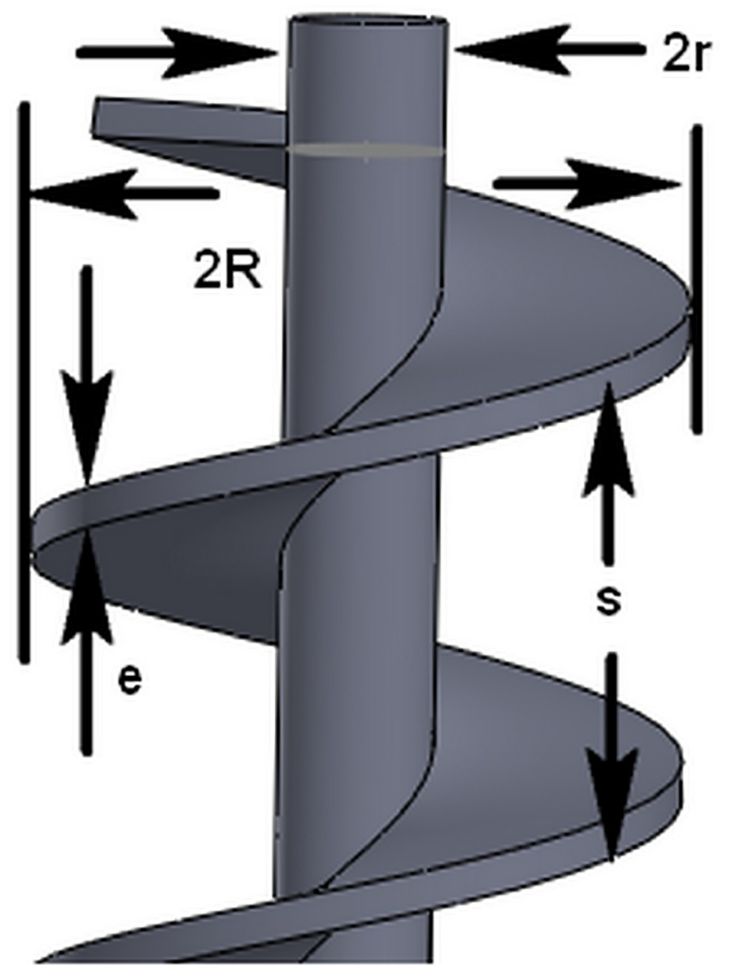
Fig 2. Schematic view of the screw conveyor structure.